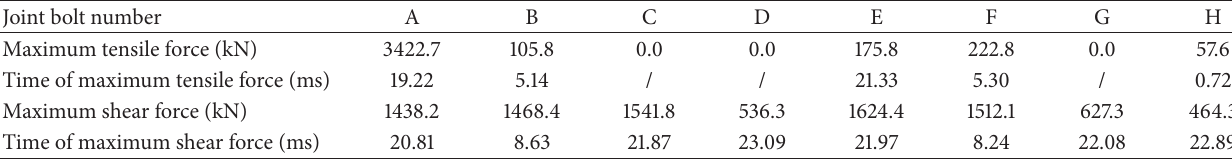
Table 7: Maximum tensile and shear forces and the failure type of joint bolts in Model